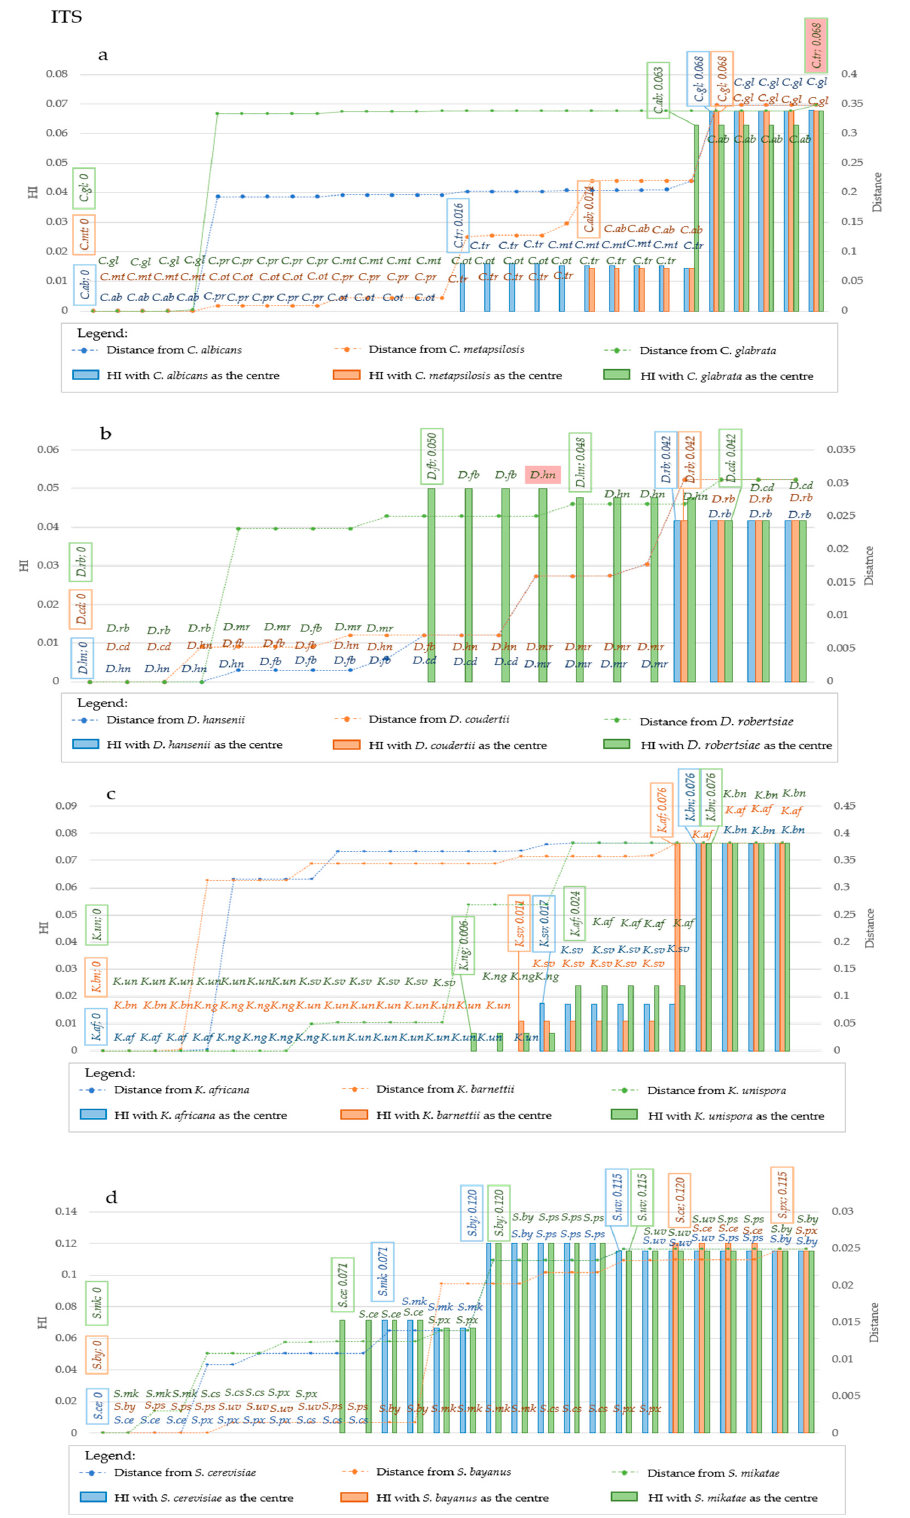
Figure 6. Homoplasy Index and Distance in ITS sequences considering different center of distribution, at strain level. The plots report the variation in Homoplasy index and distance of ITS sequences, when three different species are considered the center of the distribution. Each plot reported in the primary Y-Axis (on the left) the value of HI, while the secondary Y-Axis (on the right) reported the value of distance from the center of the distribution. In the X-Axis species are reported. Species are displayed in increasing distance order from the center, represented by the three leftmost species of each